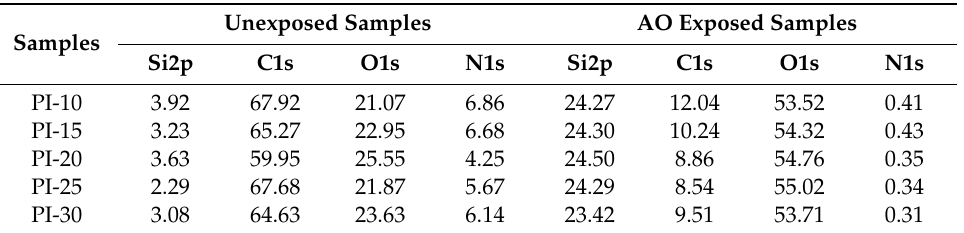
Table 4. XPS results for the unexposed and exposed POSS-PI films.